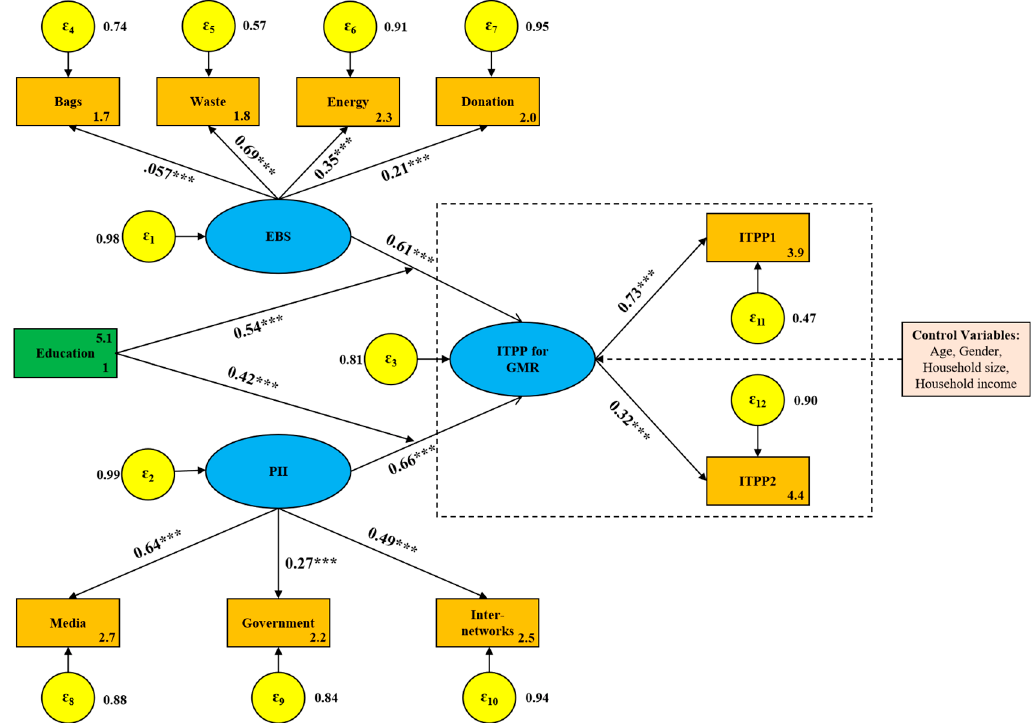
Figure 7. SPCs of the SEM with moderator. Note: the moderator, education, was also measured by the 3-point Likert-type scale from “Low” to “High”. “***”, significant 1% level.